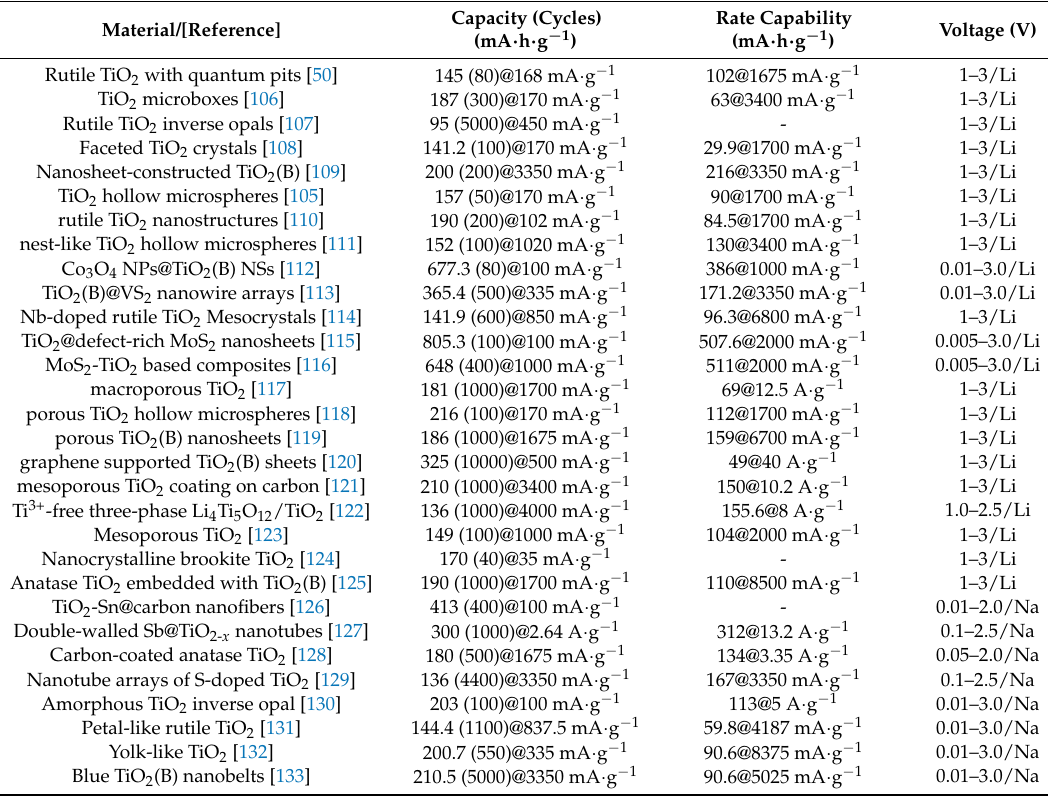
Capacity (Cycles) Rate Capability Voltage (V) (mA · h · g − 1 ) (mA · h · g − 1 )